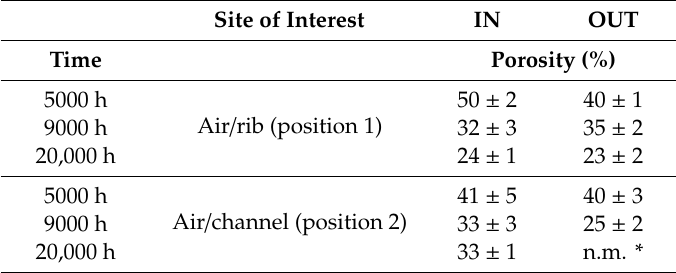
Table 4. Porosity variation of the MCO coating according to the exposition time and sampling site. Average values with standard deviations in thickness on at least 5 measurements. n.m. = not measured. * = detached. Site of Interest IN